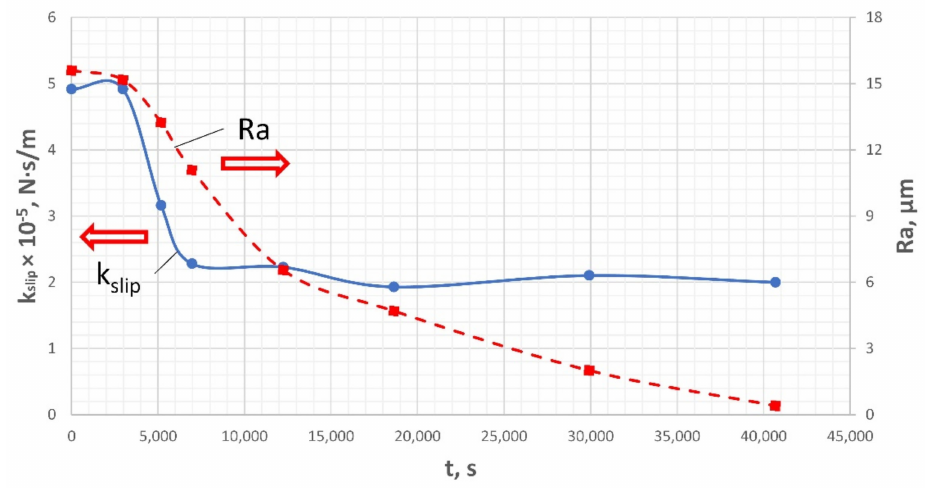
Figure 23. S-shape specimen: k slip vs. Ra (average